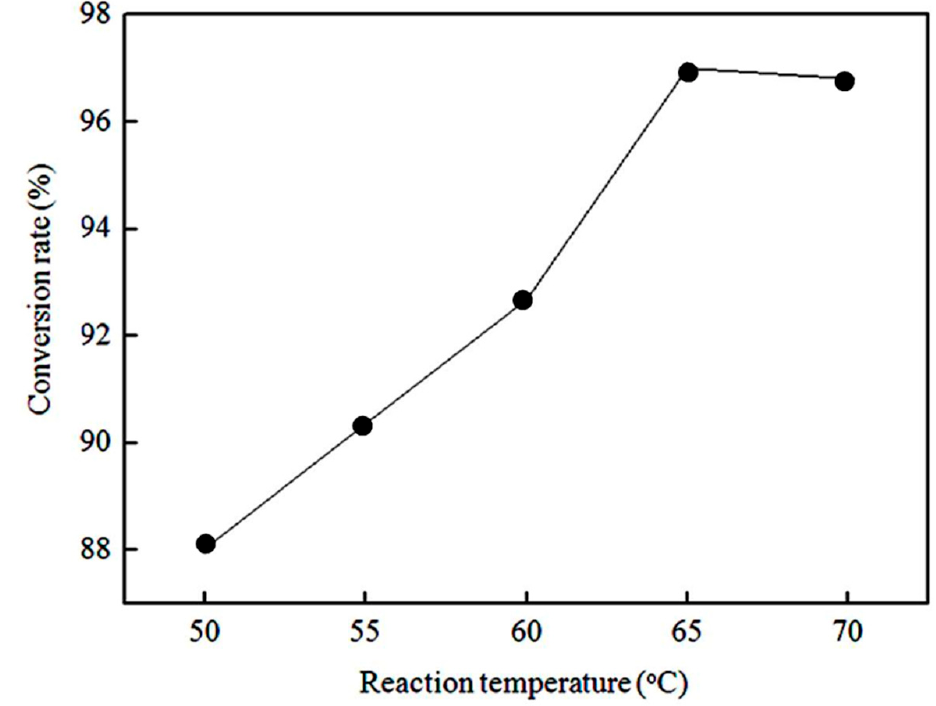
Figure 7. Effect of reaction temperature on the transesterification reaction.